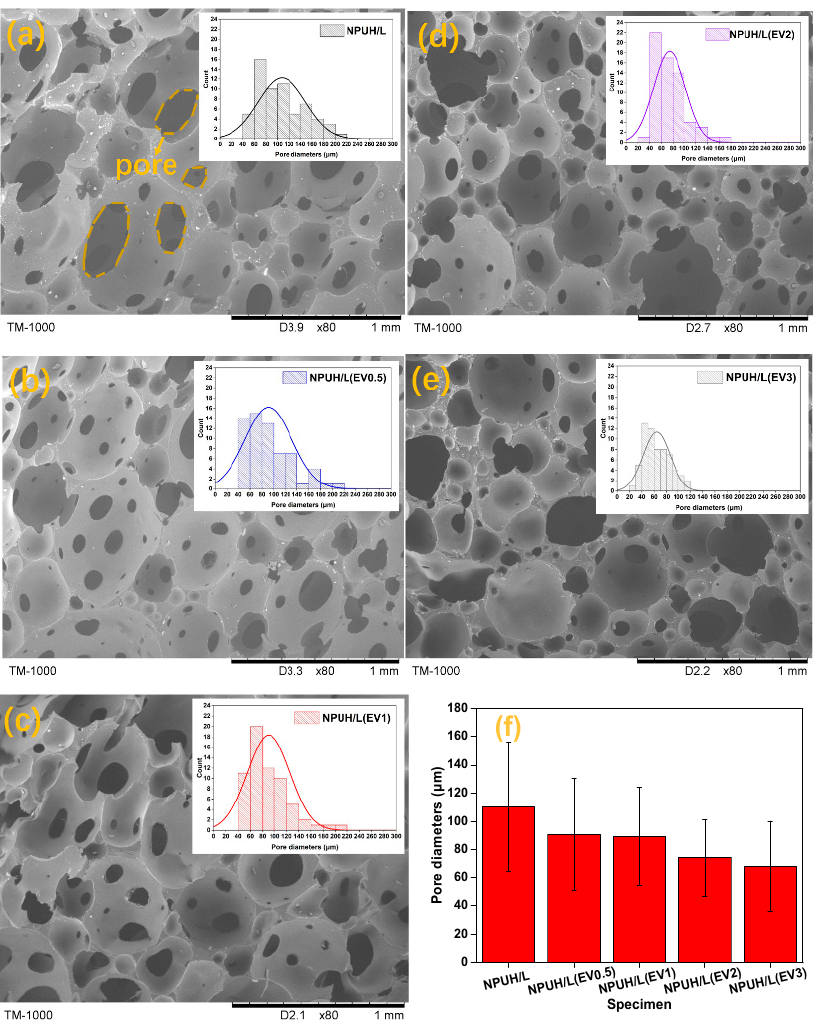
Figure 6. SEM images and pore diameter distribution of lower layer foam with different EV contents. ( a ) NPUH/L; ( b ) NPUH/L(EV0.5); ( c ) NPUH/L(EV1); ( d ) NPUH/L(EV2); ( e ) NPUH/L(EV3); ( f ) the average pore diameters.